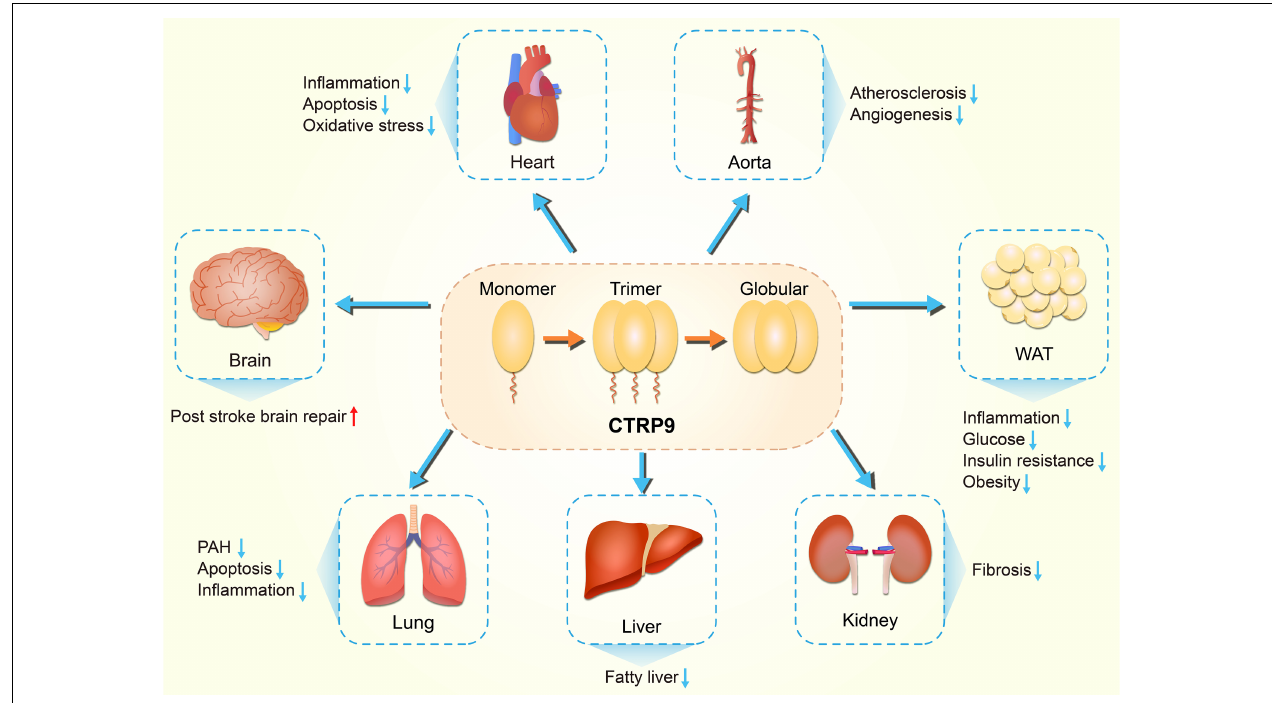
FIGURE 1 | Diversity of physiological functions of CTRP9. CTRP9 protects against various pathologic process, including inflammation, oxidative stress, and apoptosis, in diverse organs. CTRP9, C1q tumor necrosis factor-related protein 9; PAH, Pulmonary arterial hypertension; WAT, white adipose